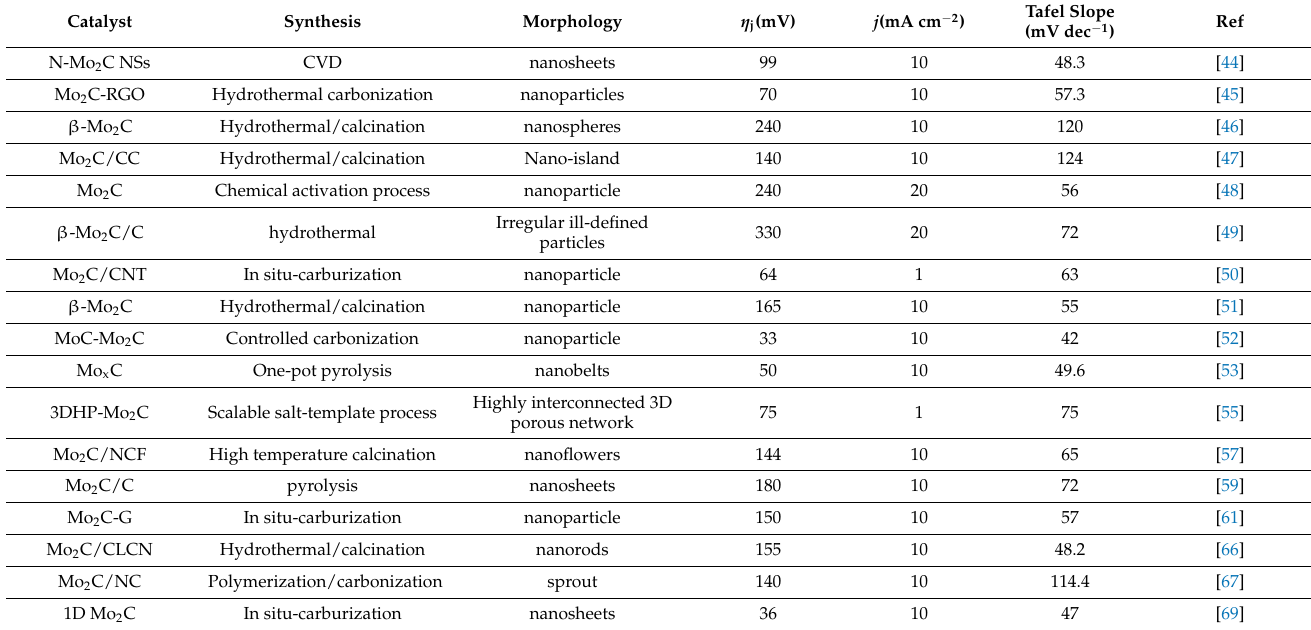
Table 1. Electrochemical characteristics of various Mo 2 C-based electrocatalysts for improved HER